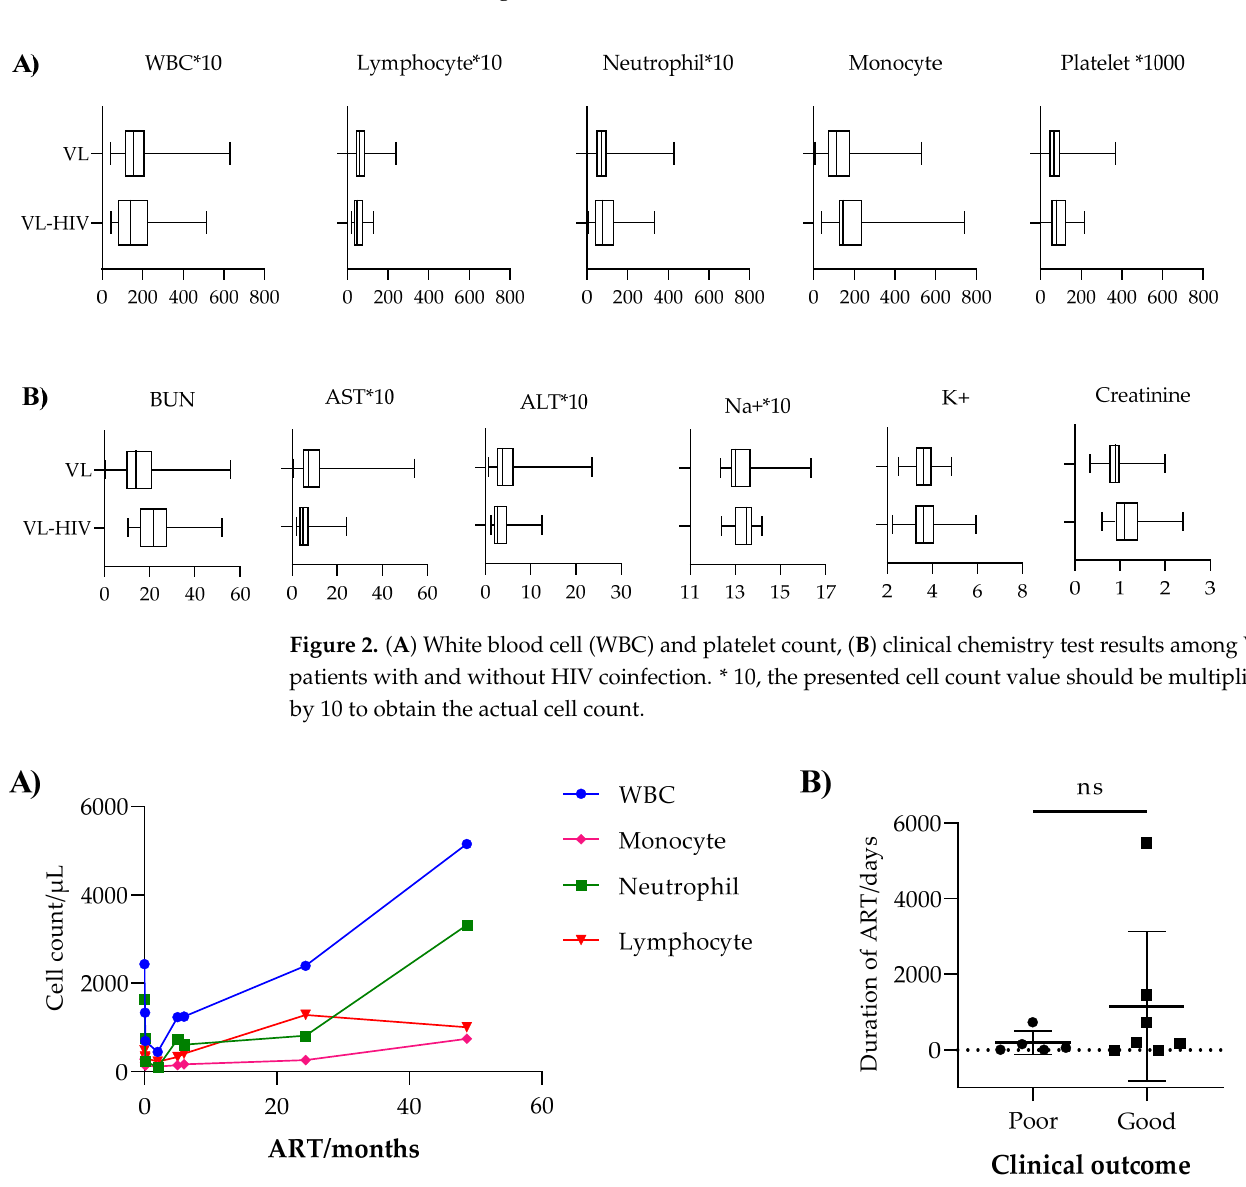
Figure 3. ( A ) Correlation of ART duration with total leucocyte count (r = 0.9, p = 0.003), monocyte count (r = 0.9, p = 0.0023), neutrophil count (r = 0.8, p = 0.017), and lymphocyte count (r = 0.8, p = 0.0155) among HIV-positive VL patients, ( B ) end-of-treatment clinical outcomes with respect to ART duration. ns, not significant. Table 2. Clinical presentations, underlying medical conditions, and hematological data among VL patients with and without HIV coinfection at the time of admission at the LRTC, Gondar, Ethiopia. VL–HIV ( n , %), n = 23